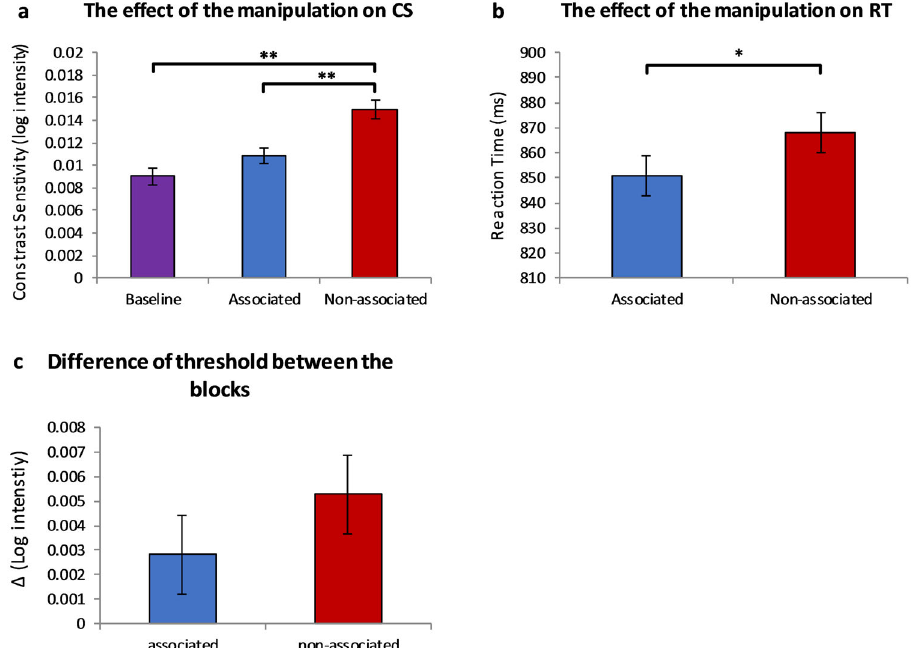
Fig. 2 Contrast sensitivity results. a The results of the three blocks (baseline, associated, and non-associated). Results presented in log intensity units. CS threshold was found to be lower in the associated block, indicates better visual performance. No signi fi cant difference was found between the baseline and the associated block. b The reaction time was found to be shorter in the associated block. c No signi fi cant difference was found in the difference of threshold between the blocks indicates that the starting block did not affect the results. Purple, Baseline; Blue, Associated block; Red, Non-associated block. Error bars indicate standard error of the mean, and asterisks indicate the signi fi cant differences between conditions (** p < 0.001, * p <